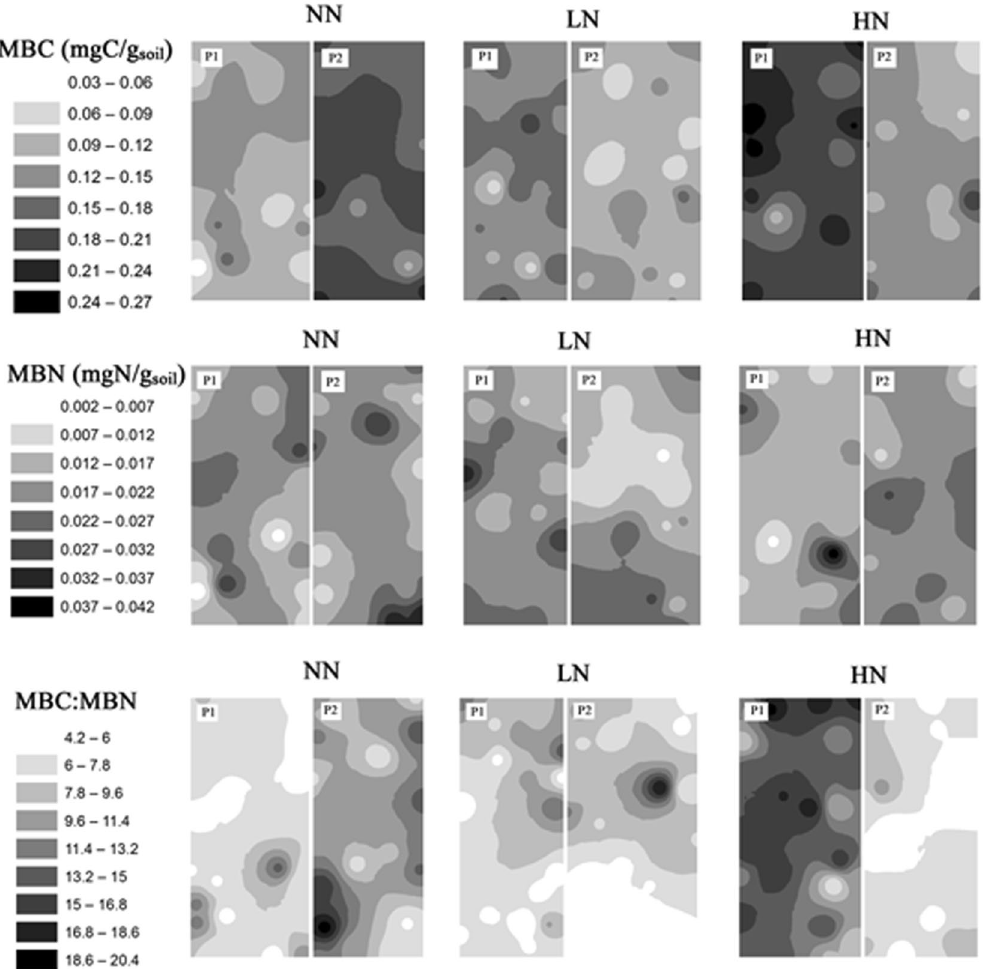
Figure 9. Spatial distribution of soil MBC, MBN concentrations and MBC:MBN under three N fertilization treatments (i.e. NN, LN and HN) in GG cropland soil in a three-year long fertilization experimental site at